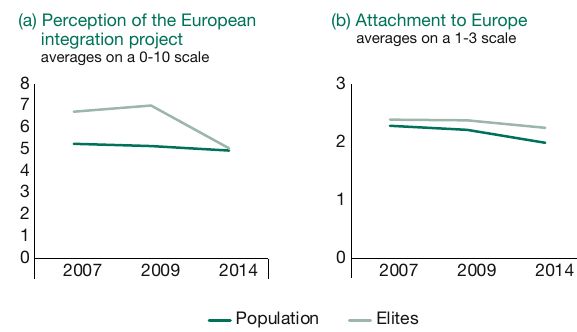
Percentage of respondents who “tend to trust” their national government and the